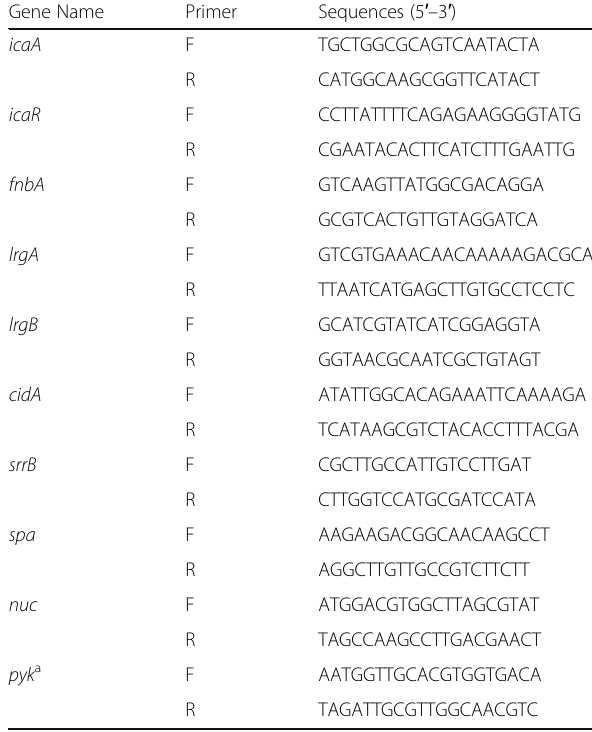
Table 1 Primers of quantitation Real-time PCR (qRT-PCR)